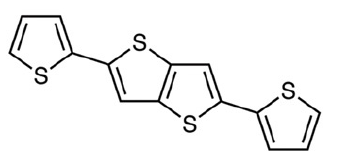
Figure 1. Structure of 2,5-di(2-thienyl)thieno[3,2-b]thiophene